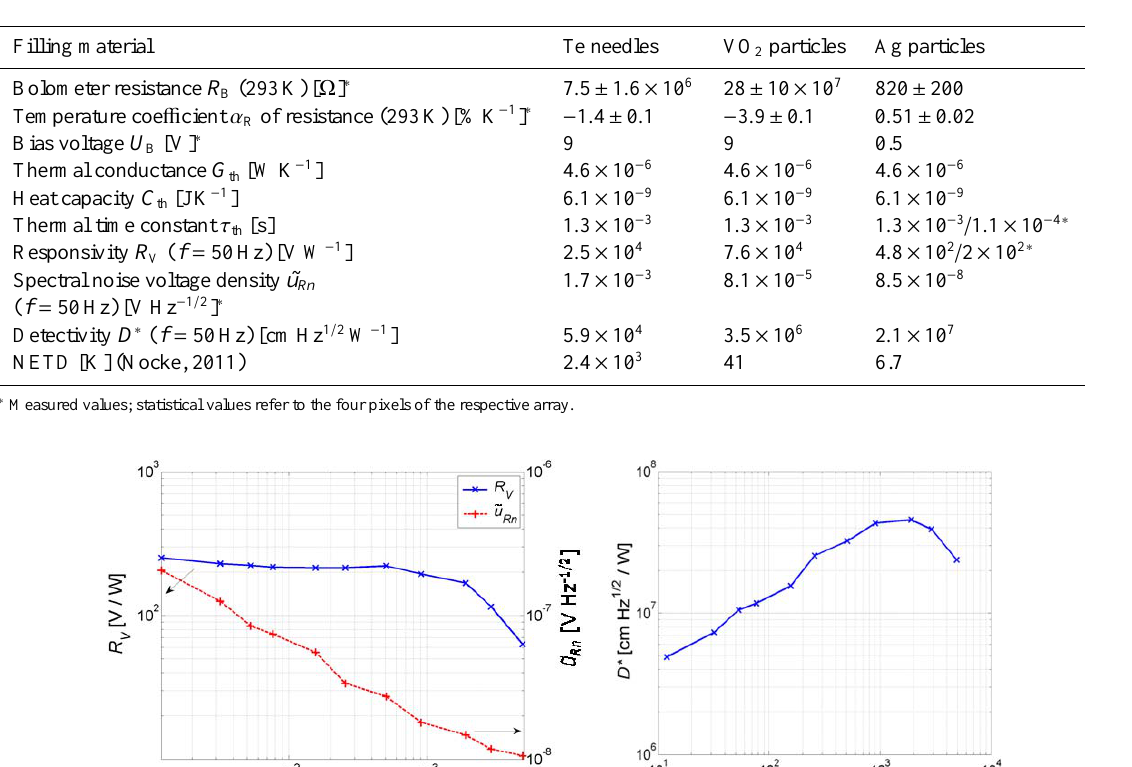
and (b) 2 Rn = 0.5 V, bolometer 4 B